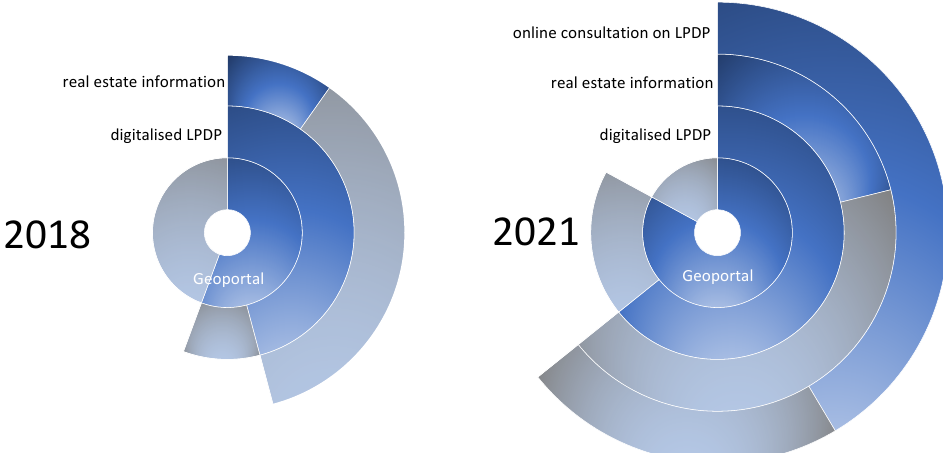
Figure 6. Changes in the core functionality of geoportals in rural gminas of Łód´z voivodeship (blue parts of the diagrams denote the presence of a given service, and grey parts the lack of a given service).